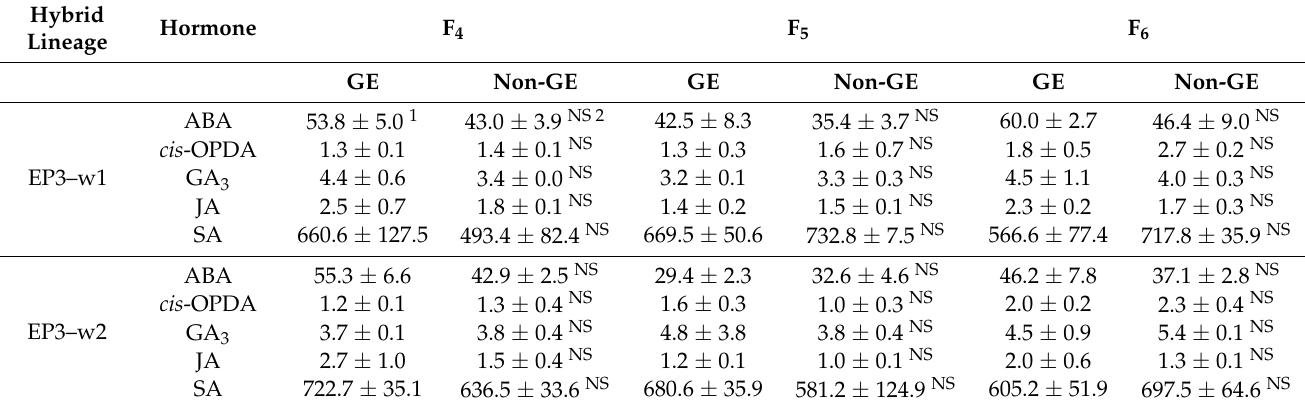
Table 3. Average contents (ng/g) of five plant hormones in genetically engineered (GE) and non-GE F 4 –F 6 imbibed seeds from hybrid lineages derived from crosses between a GE rice line (EP3) and two wild rice populations (w1 or